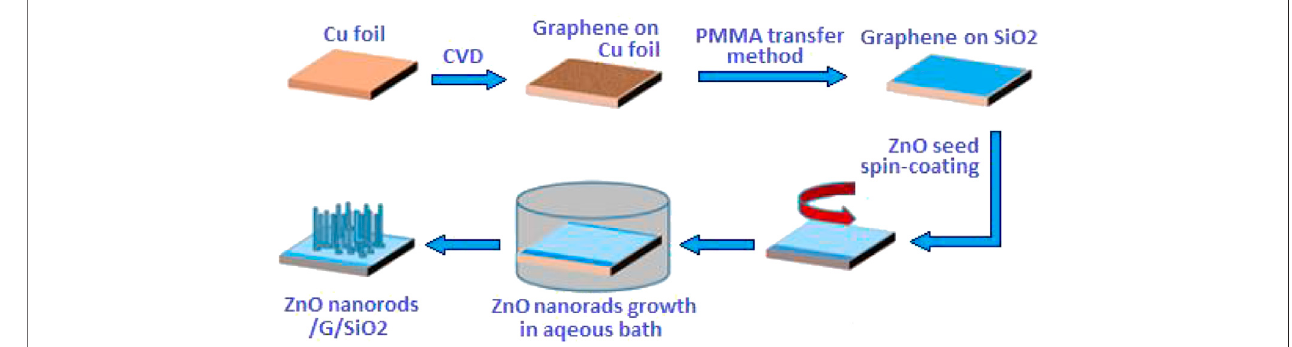
FIGURE 1 | Schematic of the fabrication process of the graphene/ZnO composite fi lm.